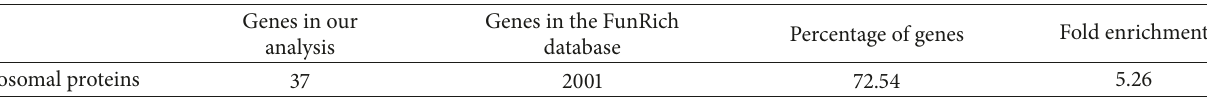
Table 5: Exosomal proteins found in urinary EVs from uninfected